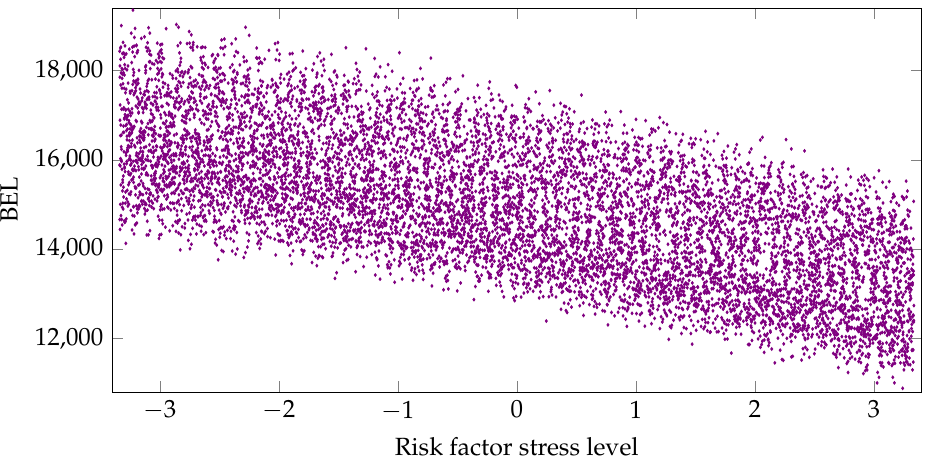
Figure 1. Fitting values of best estimate of liabilities with respect to a financial risk factor